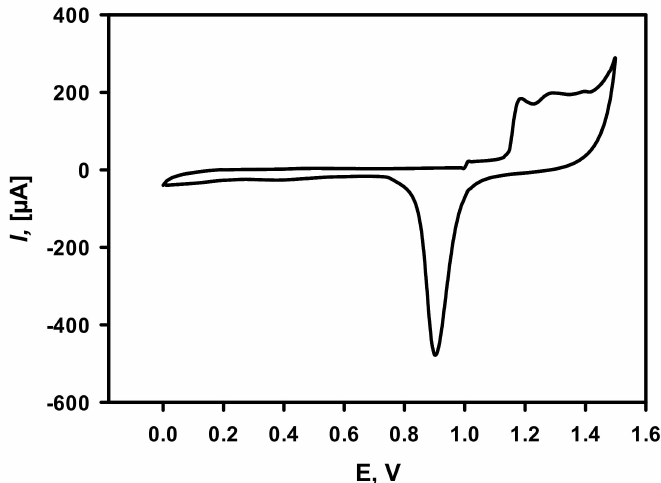
Figure 3. Cycling voltammogram of DGNs deposited on the GR electrode recorded in 0.5 M H 2 SO 4 . The scan rate was 0.1 V/s. DGNs electrodeposition was performed at a constant − 0.2 V potential for 200 s from a 10 mM solution of HAuCl 4 containing 0.1 M KNO 3